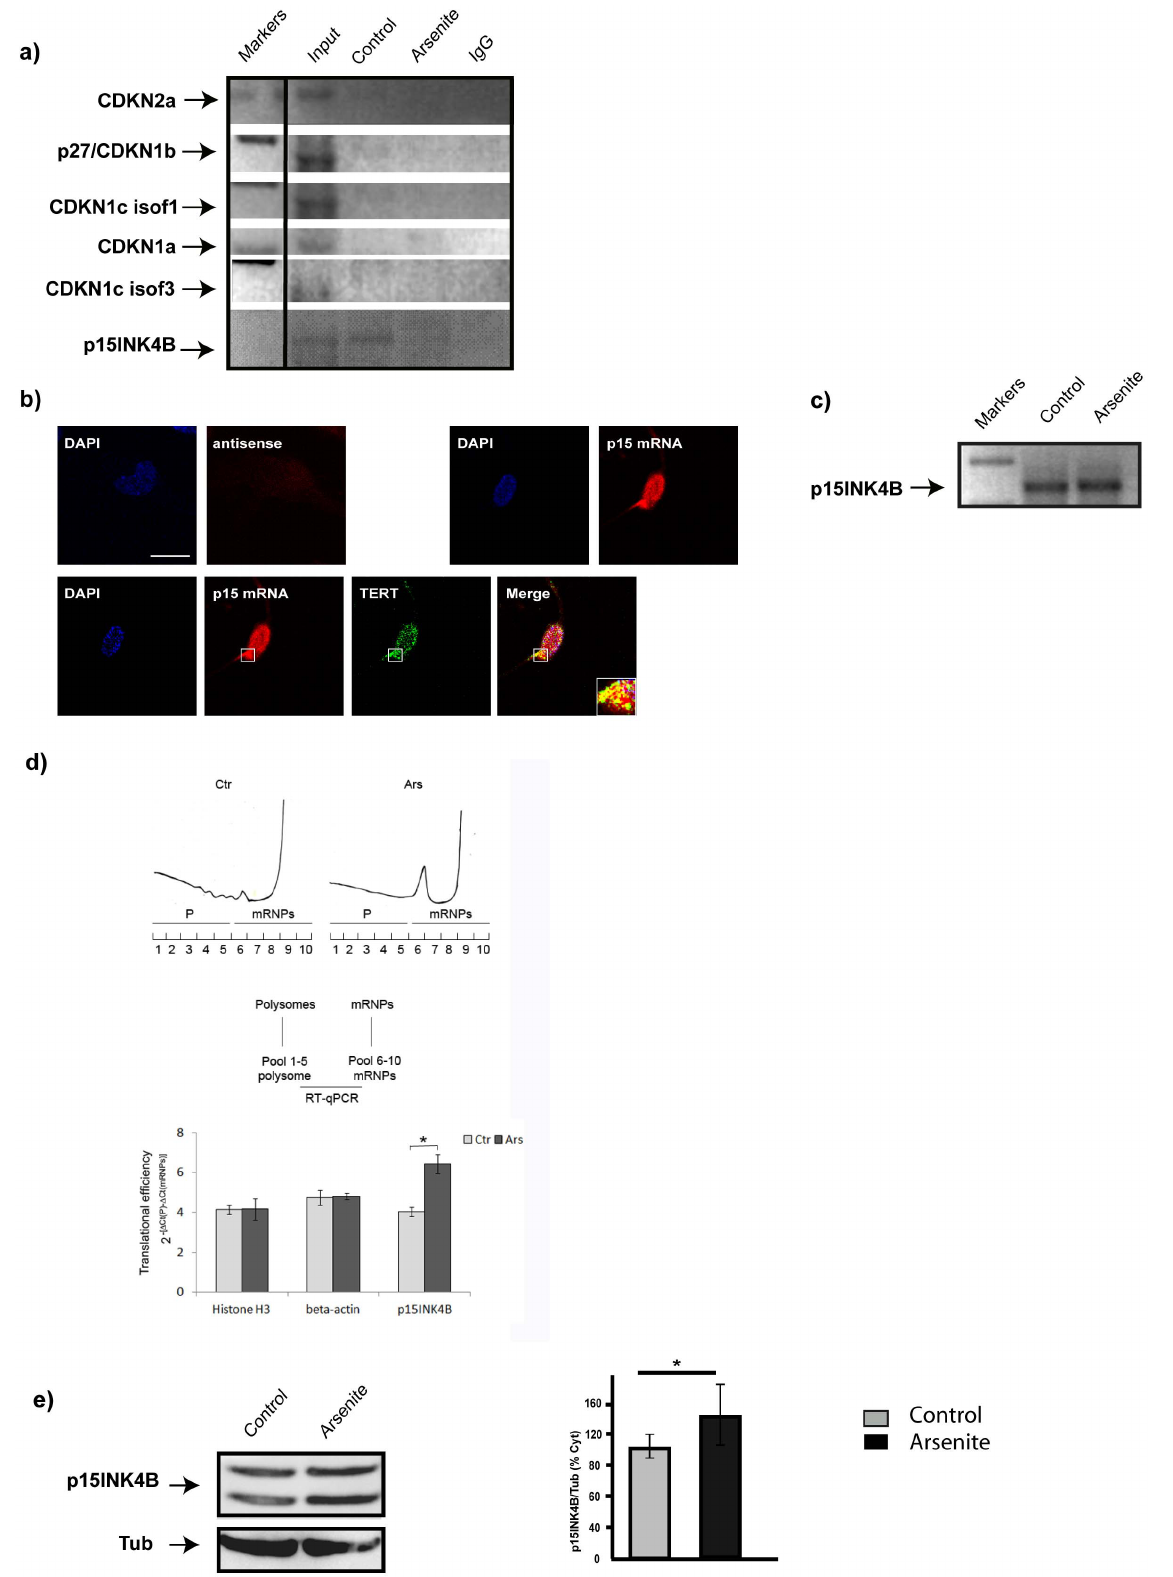
Figure 3. TERT granules contain the mRNA encoding the pro-survival cyclin inhibitor p15INK4B. a) TERT RNA-immunoprecipitation from cells under control or arsenite-induced stress: immunoprecipitated RNA was used for RT-PCR with specific primers for cell cycle regulators. Note that the only positive amplification product corresponds to the p15INK4B messenger, in the control but not stressed neurons (n=2). b) Upper panel.